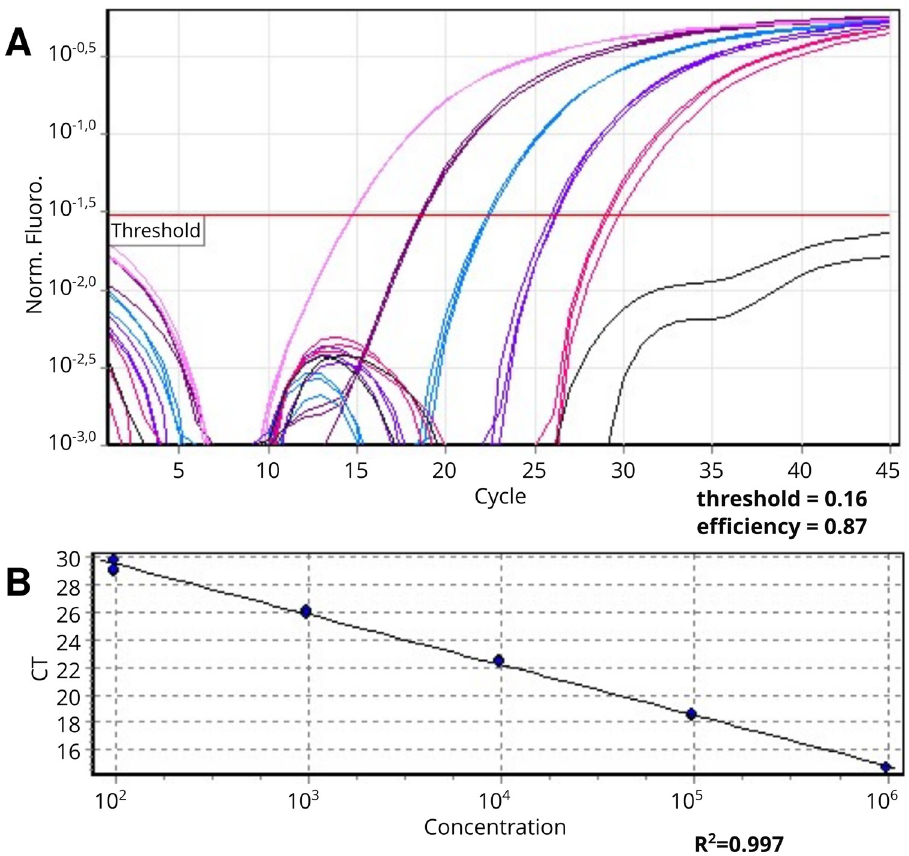
Fig 1. Standardization of qPCR using the TaqMan system. A. Standard amplification curve generated by 5 serial fold dilutions of DNA from blood spiked with T . cruzi epimastigotes DNA (from 9.8 x 10 5 to 9.8 x 10 1 parasite equivalent/mL) with threshold = 0.16, efficiency = 0.87. B . Linear regression curve and regression coefficient, R 2 =